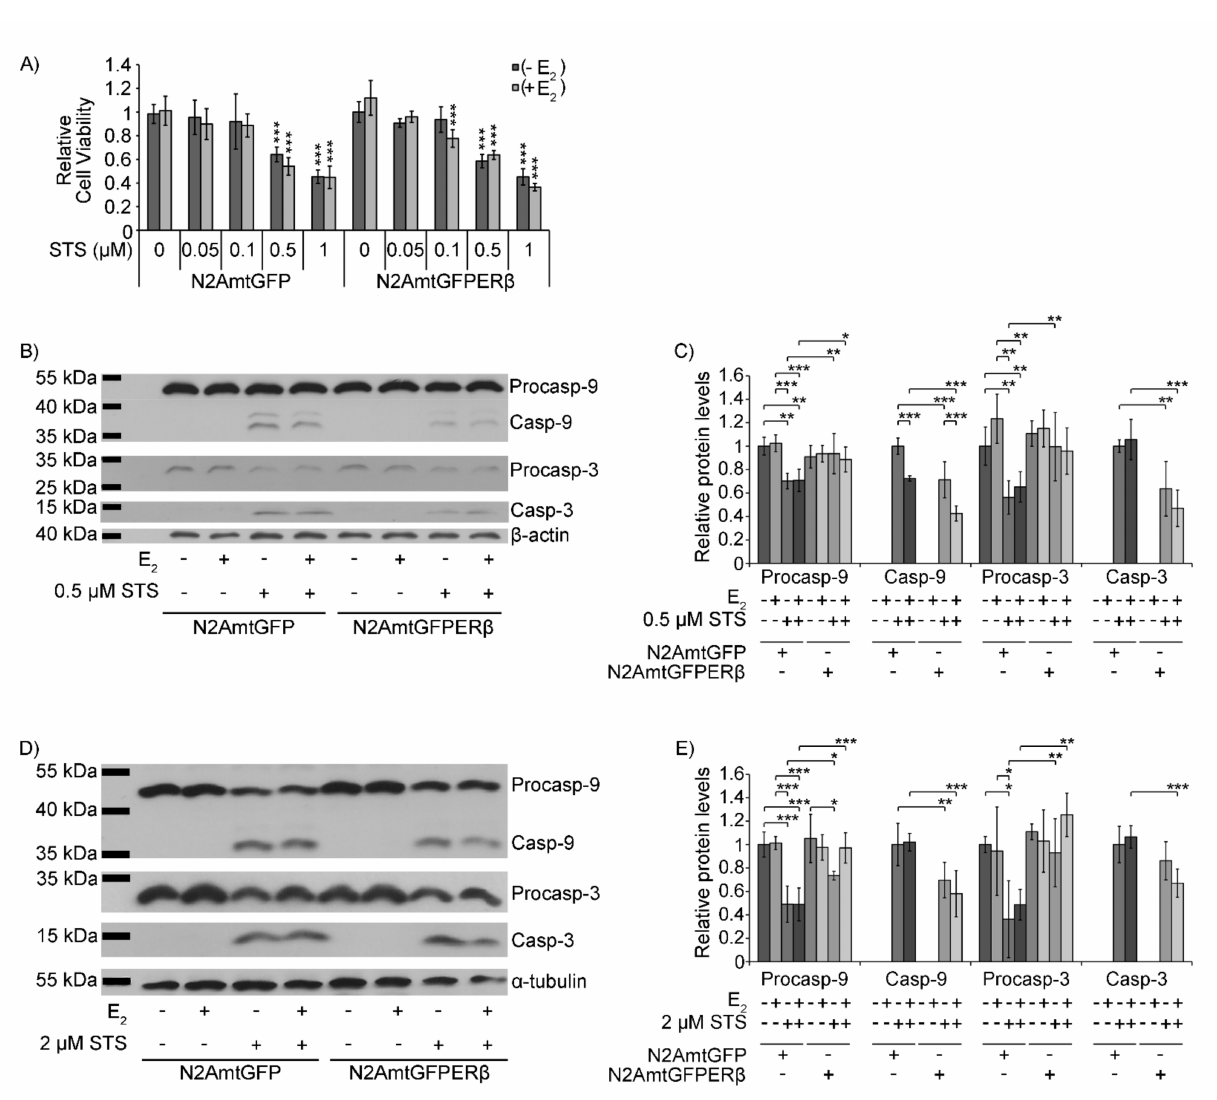
Figure 3. Protective effect of mtER β on straurosporine-induced apoptosis. ( A ) Assessment of the relative cell viability of N2AmtGFP and N2AmtGFPER β cells upon treatment with 0.05 to 1 µ M staurosporine for 12 h, in the presence or absence of 10 − 9 M E2, via MTT analysis. Data were analyzed by two-way ANOVA and expressed as mean ± S.D. ( n = 4–6), *** p < 0.001, compared to the respective vehicle-treated cells of each cell line. Western blot analysis of procaspase-9 and -3 and cleaved caspase-9 and -3, in N2AmtGFP and N2AmtGFPER β cells, treated with 0.5 µ M ( B ) and 2 µ M ( D ) staurosporine, in the presence or absence of 10 − 9 M E2, for 12 h. Western blot analysis of β -actin was applied for the normalization of the results. Quantification of the results is presented in ( C ) and ( E ) respectively. Data were analyzed by two-way ANOVA and expressed as mean ± S.D. ( n = 3–4), * p < 0.05, ** p < 0.01, *** p <